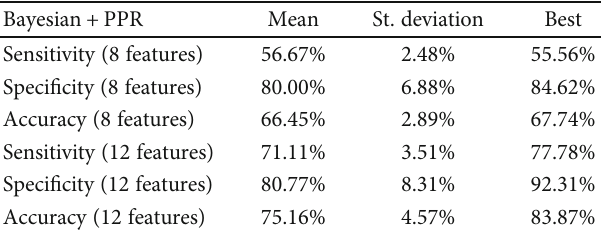
Table 15: Results of SVM with a Bayesian kernel and posterior probability regions.